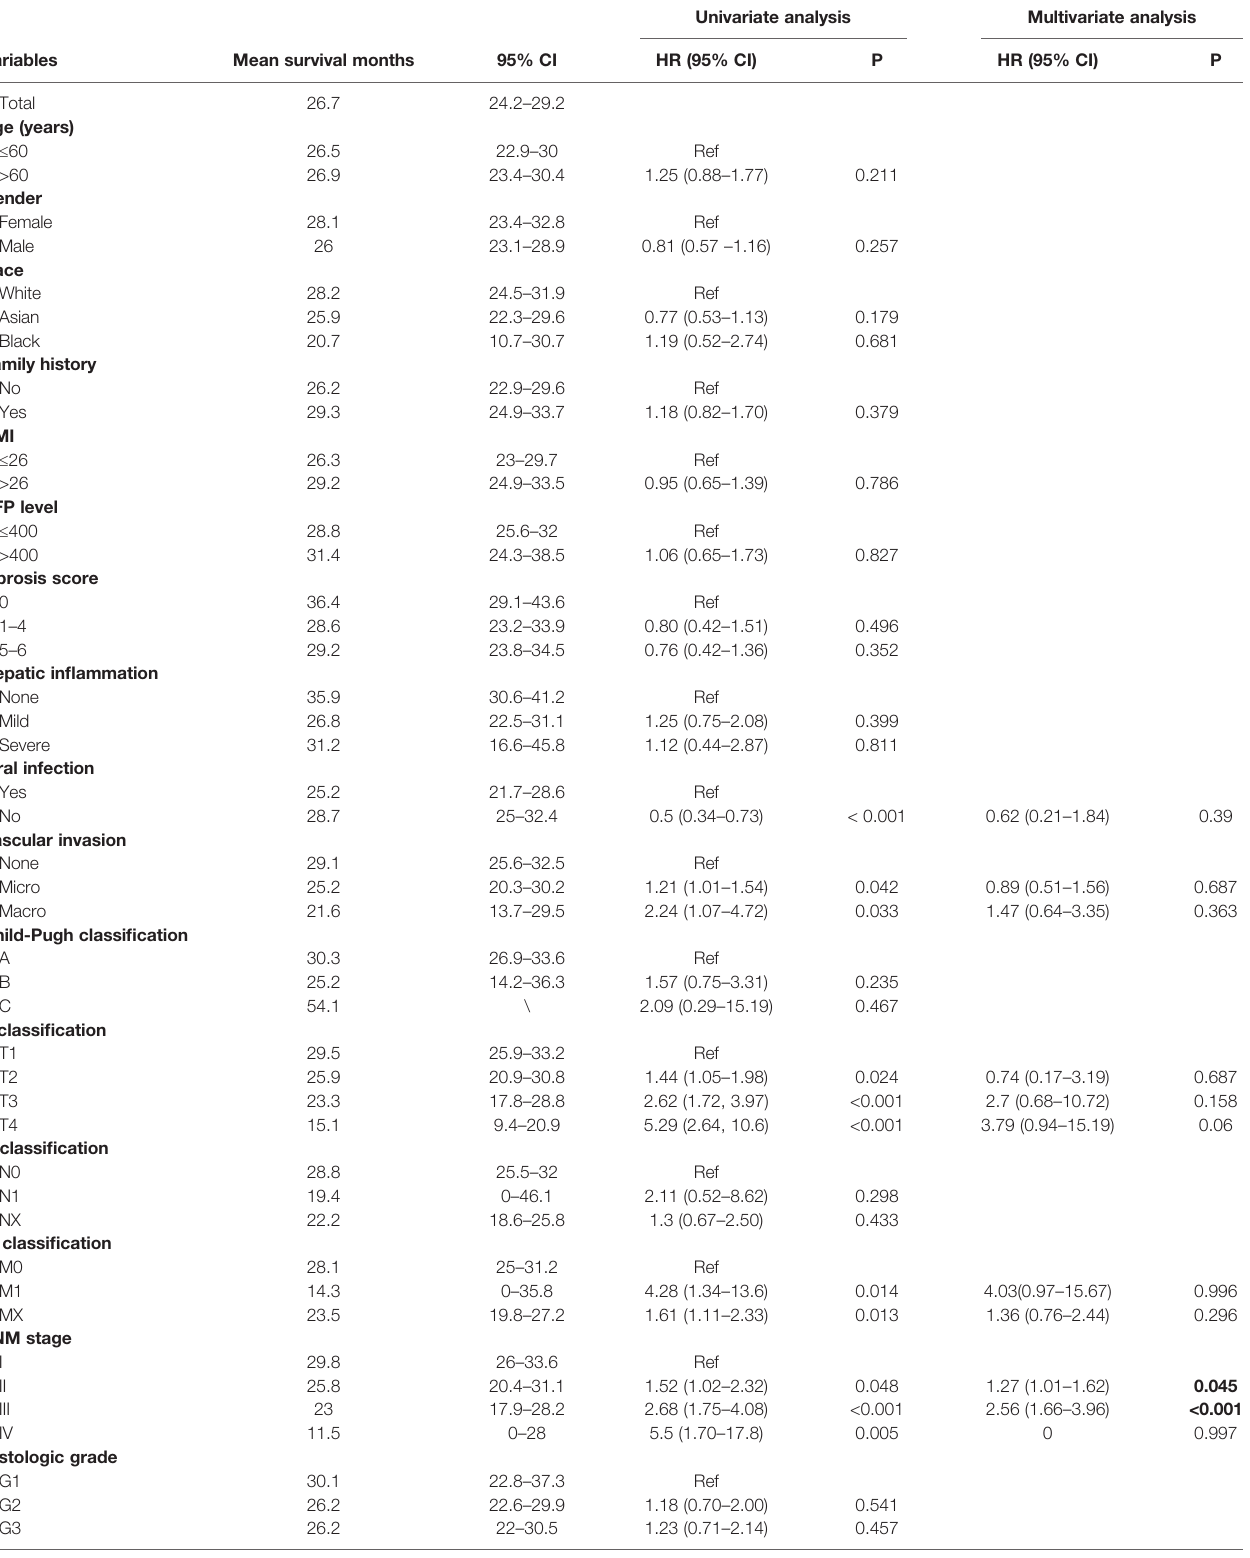
TABLE 2 | Univariate and multivariate analysis for OS of 371 HCC patients from the TCGA database. c Univariate analysis Multivariate